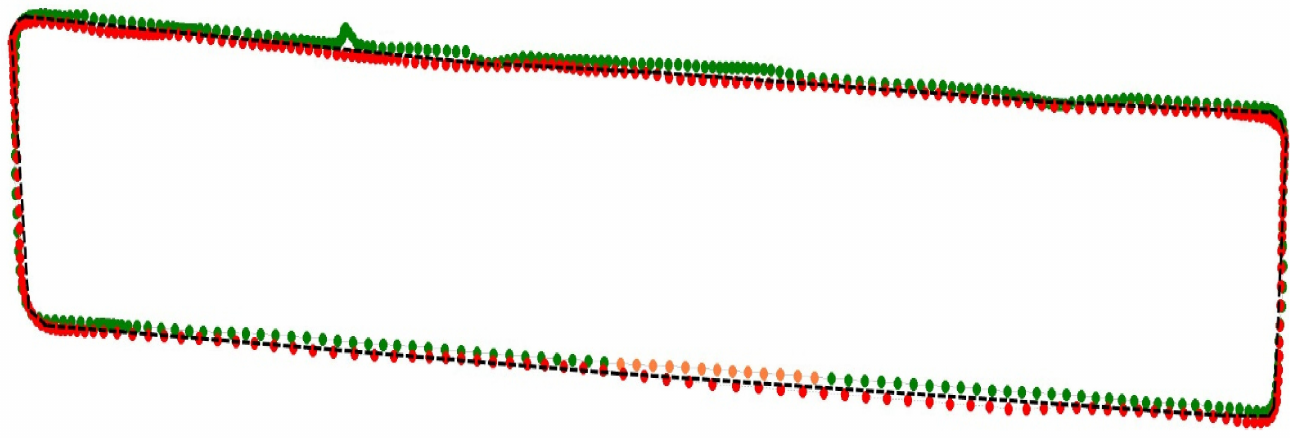
Figure 7. Comparison of two navigation modes.